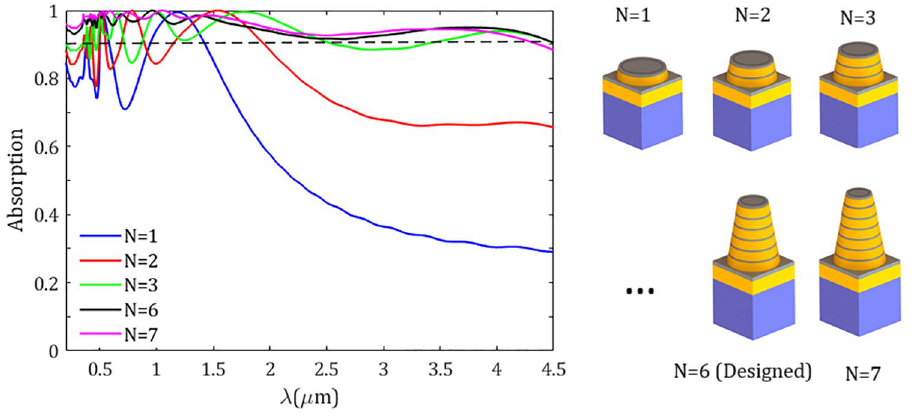
Figure 5. Absorption spectra of the proposed metasurface absorber for a different number N of layers forming the TiN/Ti O 2 rings.